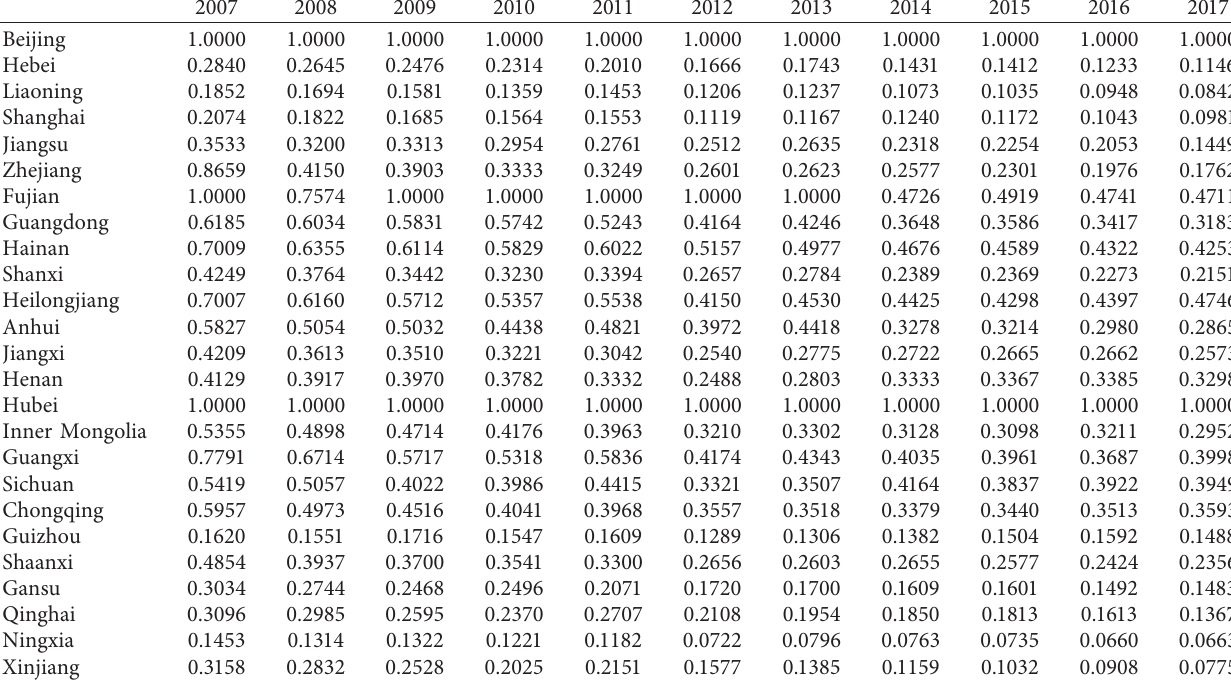
Table 2: Calculation results of Malmquist index of carbon emission reduction technology of 25 provinces.